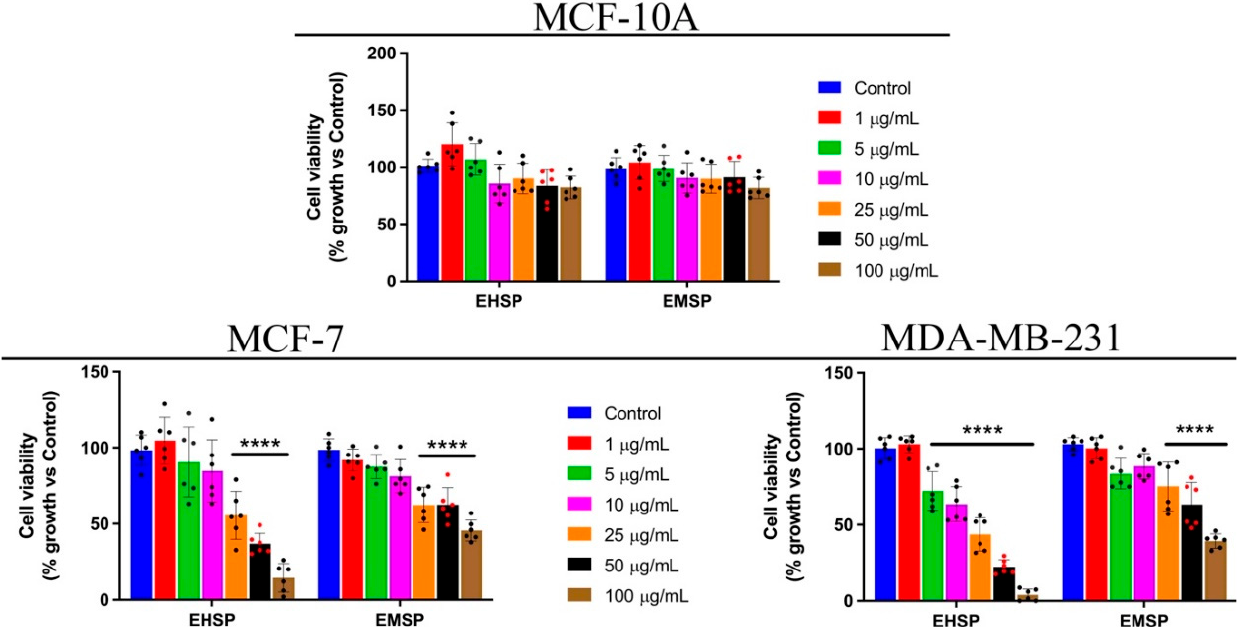
Figure 1. MCF-10A, MCF-7 and MDA-MB-231 viability after EHSP or EMSP treatments (from 100 to 1 μ g/mL), for 72 h. MTT assay was used to assess cell viability. Values represent means ± SD from three independent experiments ( n = 6). Statistical analysis was performed using one-way ANOVA analysis. **** p < 0.0001. Table 3. Cytotoxic activity of n -hexane (EHSP) and methanol (EMSP) extracts. Cell